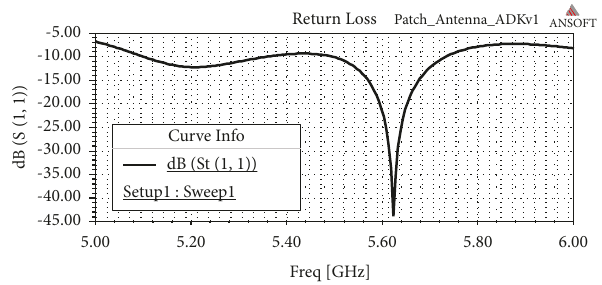
Figure 17: The return loss versus frequency of the proposed an-